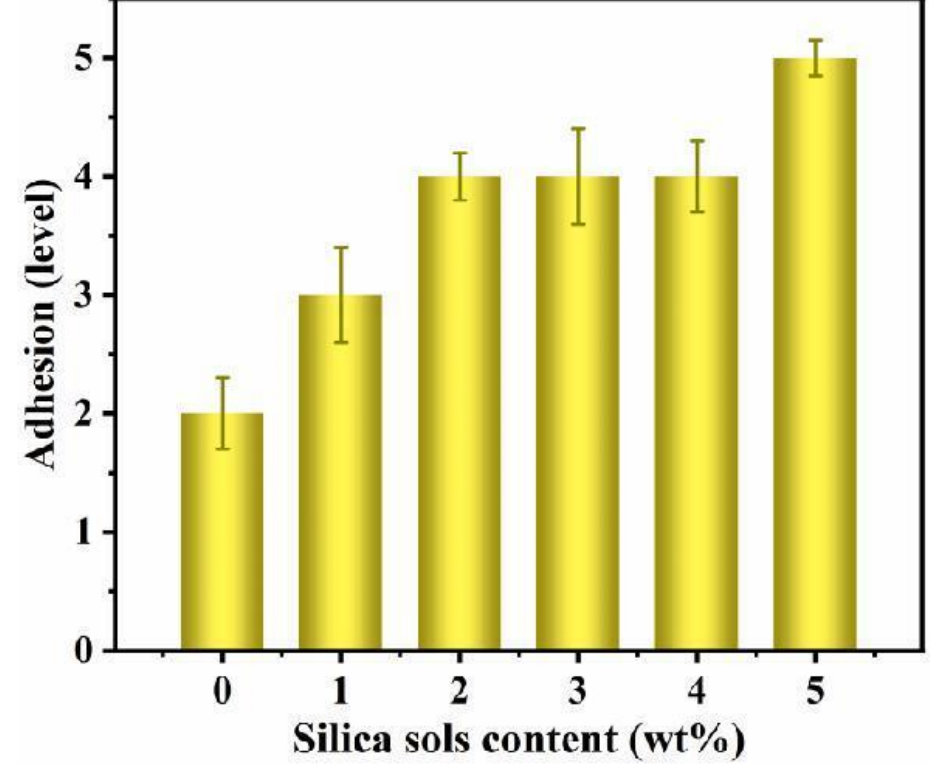
Figure 6. Effect of silica sol content on the adhesion of UV-curable WA coatings.